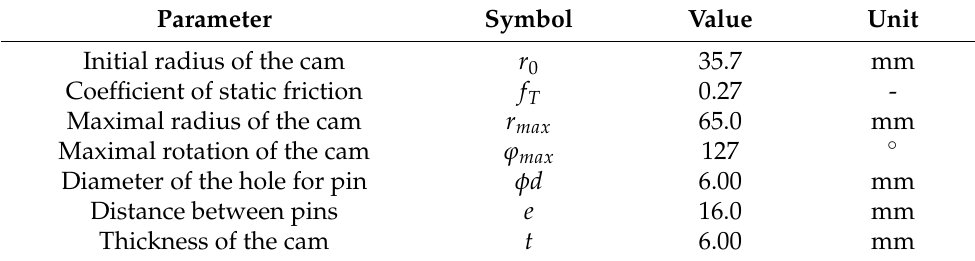
Table 5. Parameters representing the initial geometric model of the cam.